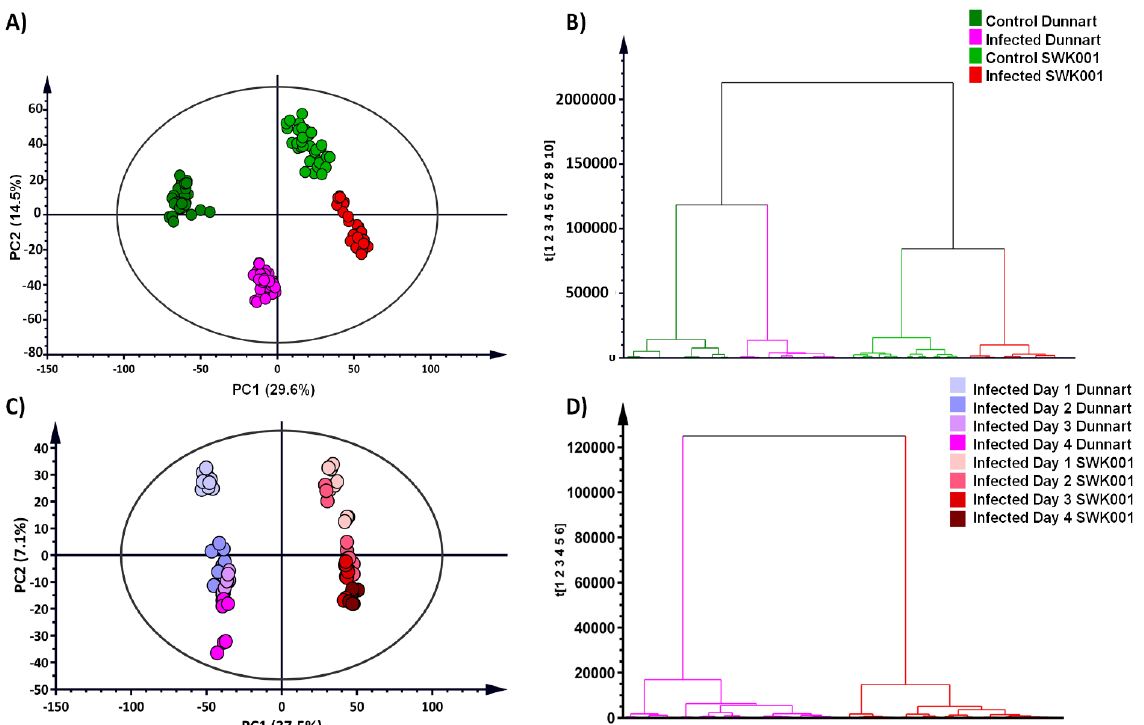
Figure 3. Principal component analysis (PCA) of the two infected oat cultivars with the corresponding hierarchical cluster analysis (HCA) dendrograms. PCA scores plots indicate the clustering and general grouping among the infected and control groups for “Dunnart” (dark green/pink) vs. “SWK001” (light green/red) analysed in ESI(–) mode. ( A ) PCA scores plots of all the samples showing the infected and control groups as indicated. ( C ) PCA scores plot illustrating all infected samples from 1–4 d.p.i. for “Dunnart” ( left ) and “SWK001” ( right ). ( B , D ) HCA dendrograms (corresponding to PCA plots ( A ) and ( C ), respectively) showing the hierarchical structure of the data, indicating that the control and infected groups for “Dunnart” and “SWK001”, respectively, cluster together and are grouped separately from one another. In ( D ) the infected groups for “Dunnart” are clustered separately to the left and the infected groups of “SWK001” to the right. The unsupervised modelling tools allowed a comprehensive overview of the data (PCA) and grouped the samples with regard to their treatment-related differences from 1–4 d.p.i. and their natural clustering based on cultivar- dependent variation